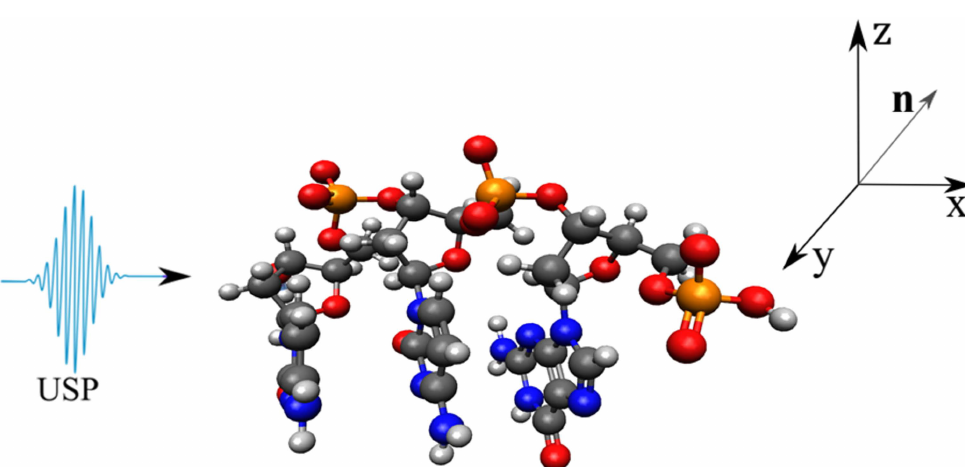
Figure 4. The same as in Figure 1, but only for trinucleide